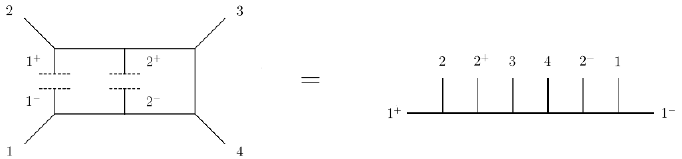
Figure 18 . Another contribution to a planar double-box, here with a di(cid:11)erent placement of the loop momenta. In this example, we have a master